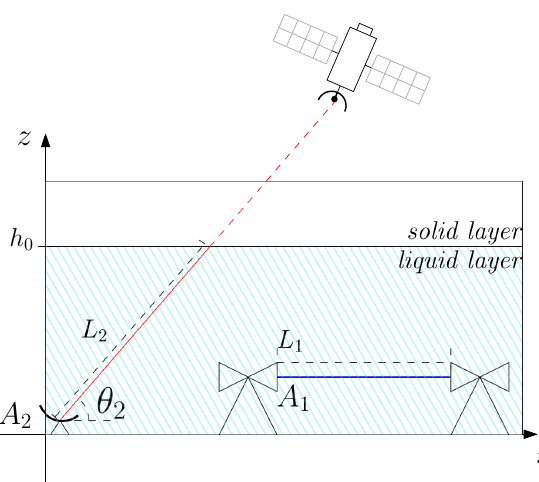
Figure 1. Stratiform rain model and geometry of the scenario. Link 1: CML, with length L 1 , atten- uation A 1 and elevation angle θ 1 = 0. Link 2: BSL, with wet path length L 2 , attenuation A 2 and elevation angle θ 2 .